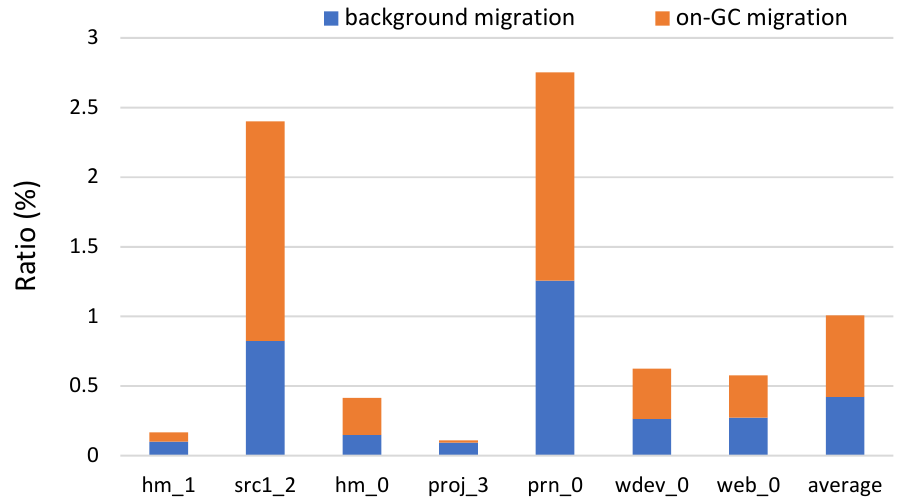
Figure 8. GC-aware migration and GC-piggybacked migration’s cost to the total number of pro- gram